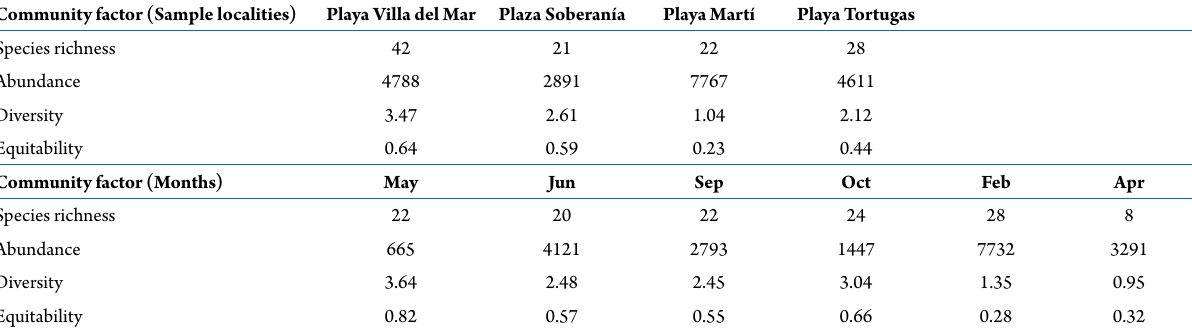
Table 5. Community factors of larvae and macro-crustaceans during six months of sampling along the coastline of the Parque Nacional Sistema Arrecifal